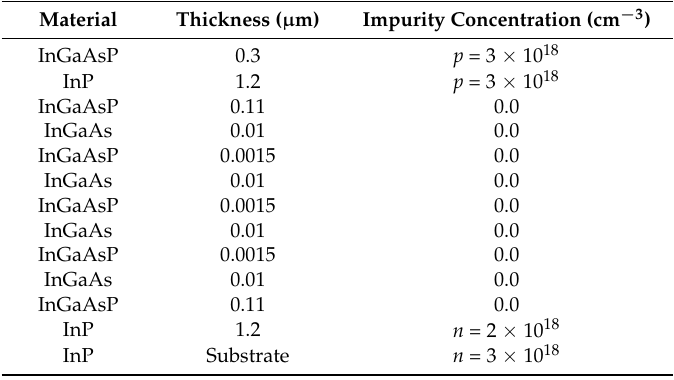
Table 1. Layer structure of InGaAsP crystals used in Ref.